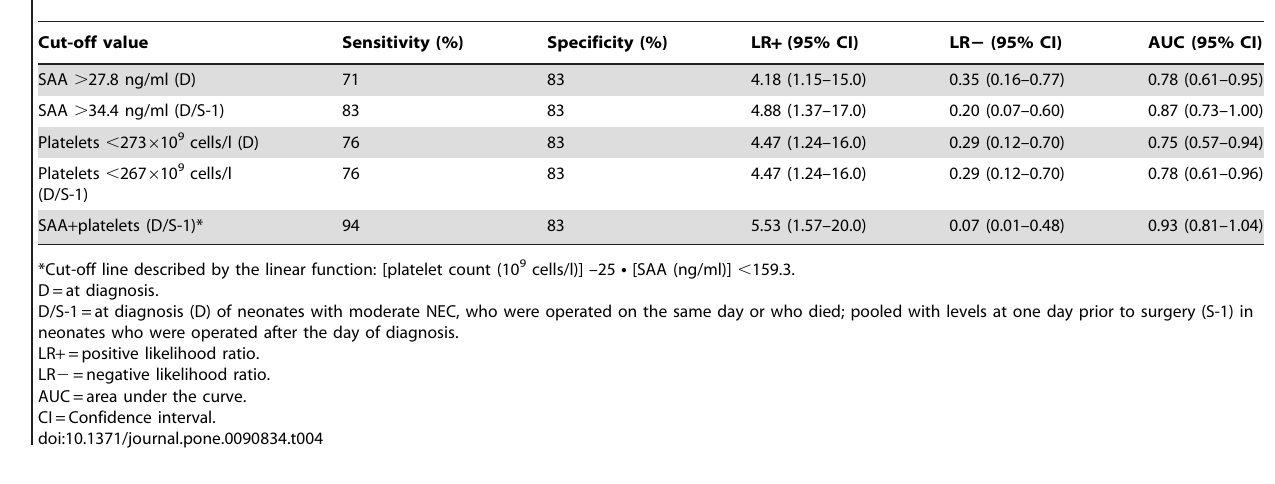
Table 4. Test characteristics of urinary SAA and platelet count.